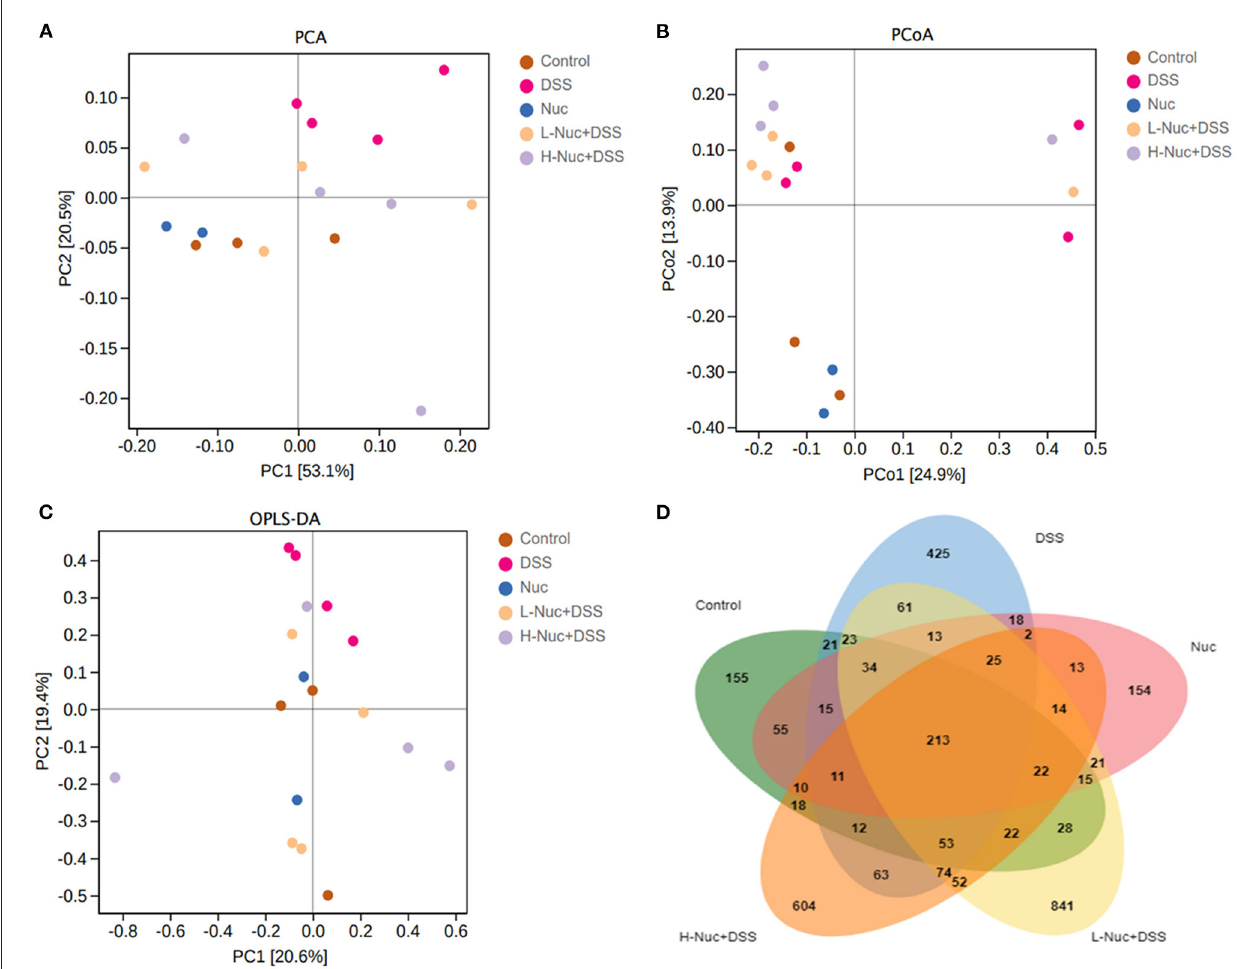
FIGURE 7 | Change of gut microbiota structure in DSS-induced UC mice model under different drug interventions ( n = 4). (A) Principal components analysis (PCA) for DSS- induced UC mice model with different treatments. (B) Principal coordinates analysis (PCoA) for DSS-induced UC mice model with different treatments. (C) Orthogonal Partial Least Squares Discriminant Analysis, and (D) Venn diagram